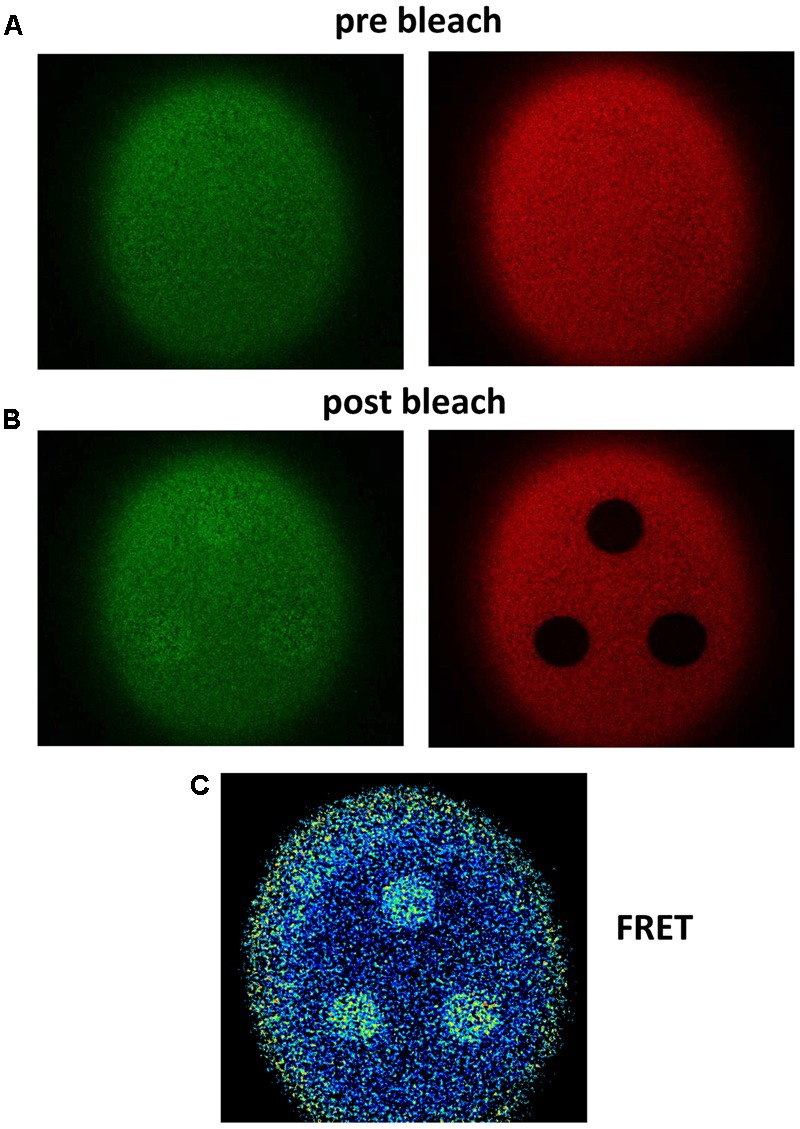
Fluorescence signals before and after acceptor photobleaching. Example of Donor (GFP) recovery after acceptor (RFP) photobleaching for the P2X4 construct with a C-terminal tandem GFP-RFP label. (A,B) Pre-bleaching (A) and post-bleaching (B) fluorescence images were obtained as described in the Methods section using a confocal laser scanning microscope. The slightly increasing GFP fluorescence is shown on the left side and the RFP fluorescence, which is strongly decreased due to application of the maximal RFP exciting light for 1 min on the right side. (C) The FRET signal was calculated pointwise using the microscope software in the same manner as shown in Figure 2. A strong FRET signal is measured in areas of RFP bleaching. Blue pixels indicate low and yellow pixels high FE.